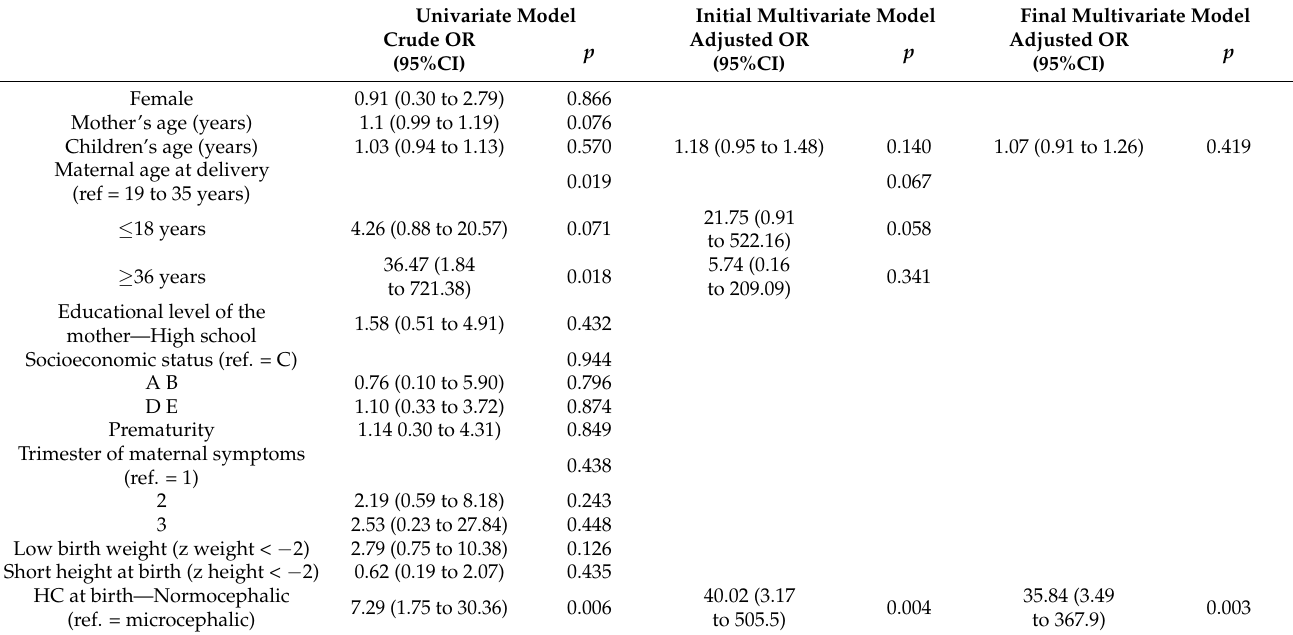
Table 4. Logistic regression models for risk of behavior